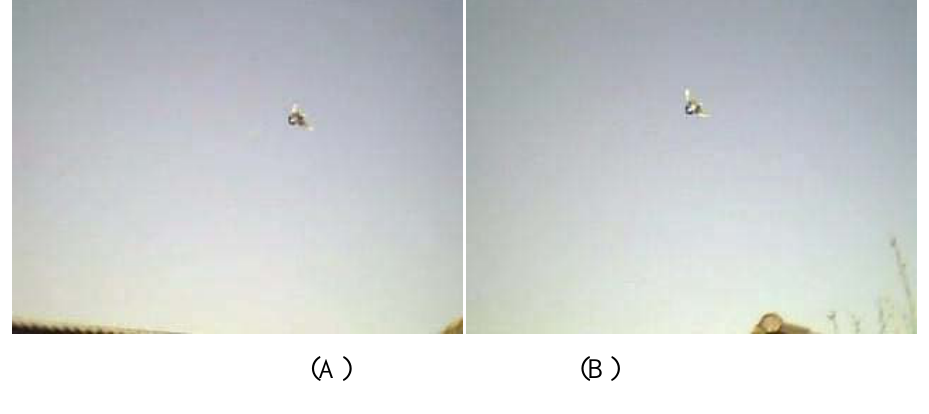
Figure 14. Two stereo pairs of airborne pigeons. Model application revealed that the birds were flying at approximately 6 m ((A) & (B)) and 4.5 m ((C) & (D)) altitude,